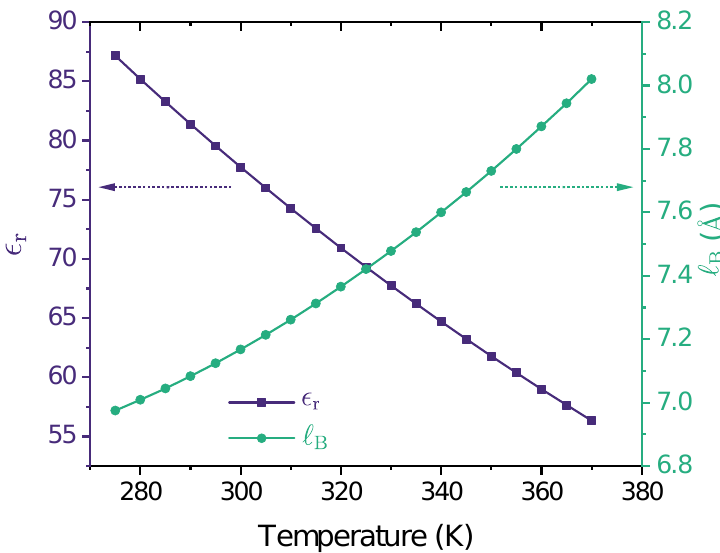
Figure 3. Relative dielectric constant (cid:101) r (left y-axis) and the corresponding Bjerrum length (cid:96) B (right y-axis) are shown as a function of temperature for liquid water at 1 atm. In preparing this fig- ure, we used Malmberg and Maryott’s empirical model [114] of the dielectric constant of water, (cid:101) r ( T ) = 87.740 − 0.40008 T + 9.398 × 10 − 4 T 2 − 1.410 × 10 − 6 T 3 , where T is the temperature value in degrees Celsius